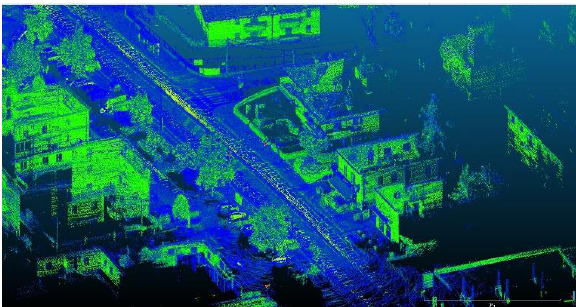
Figure 9. 3D point cloud by Kaarta Stencil 2 obtained surveying Via San Polo